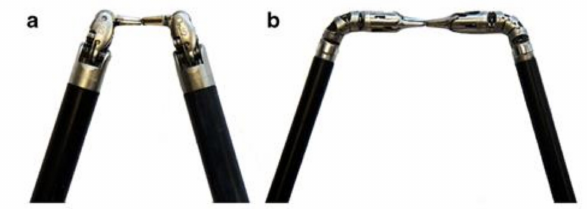
Figure 6. Comparison of the DaVinci 8 mm ( a ) and 5 mm diameter instruments ( b ). Due to their tentacle-like continuum tool shafts, the smaller diameter instruments need more operative space than the 8 mm instruments and are therefore not suitable in smaller cavities, such as infants. Figure taken from Marcus 2015